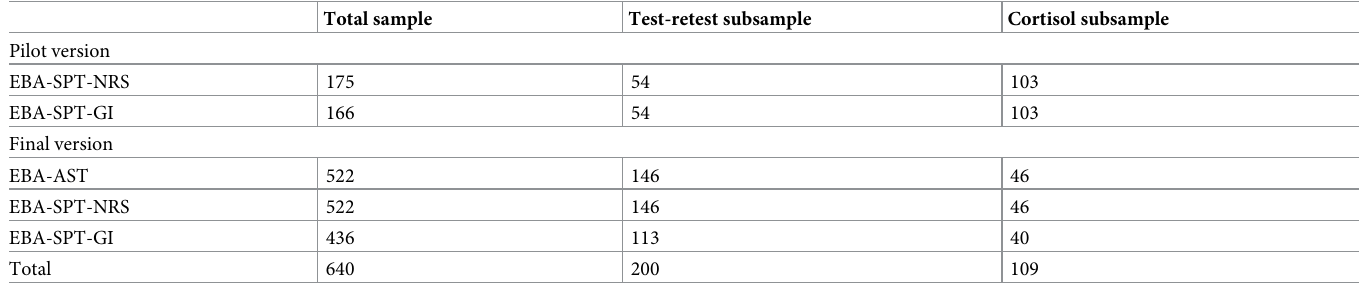
Table 1. Summary of the numbers of participants in the whole sample and concrete